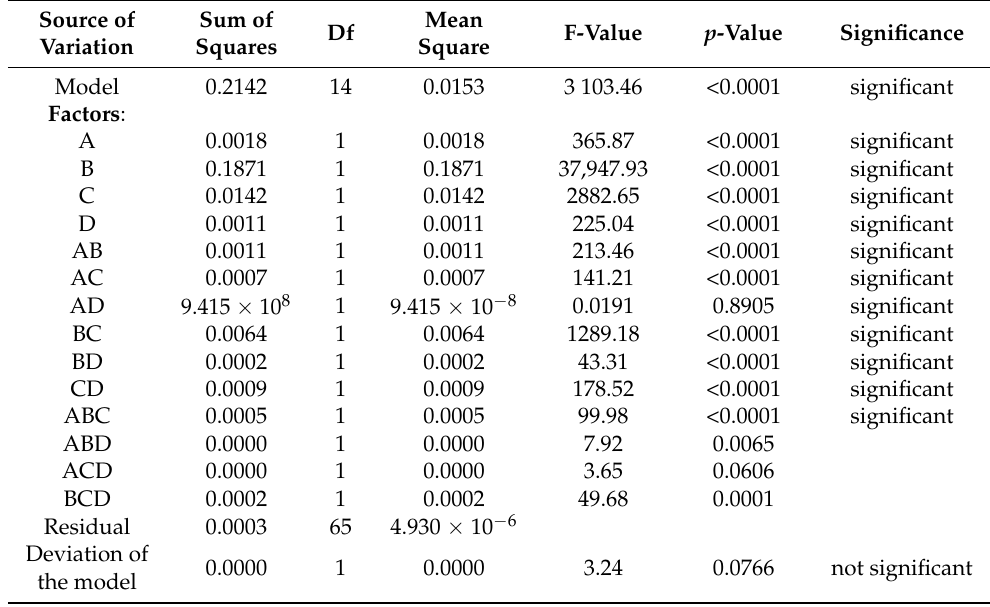
Table 7. ANOVA—DBR.